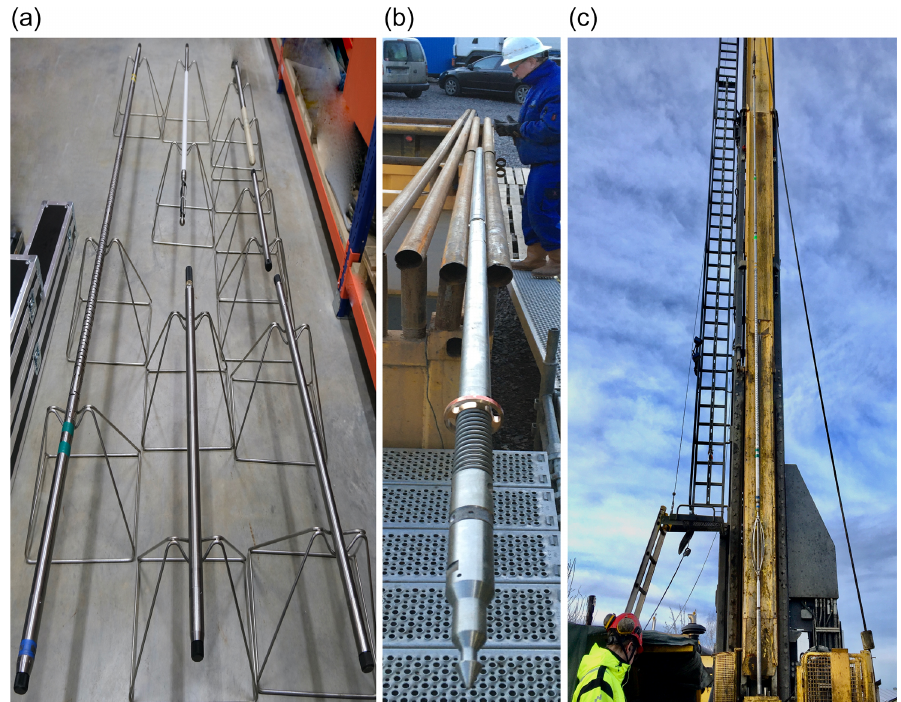
Figure 3. Sondes of the ICDP memory-logging system (iMLS): (a) mBCS, mDIL, mMS, MemBat, mTS, and mSGR (clockwise from left). (b) Landing unit with fishing spear head, spiral spring shock absorber, and brass landing plate. (c) The completely assembled iMLS tool string hanging in a wireline drill derrick before being dropped into a HQ drill string down to the coring bit at 500m.